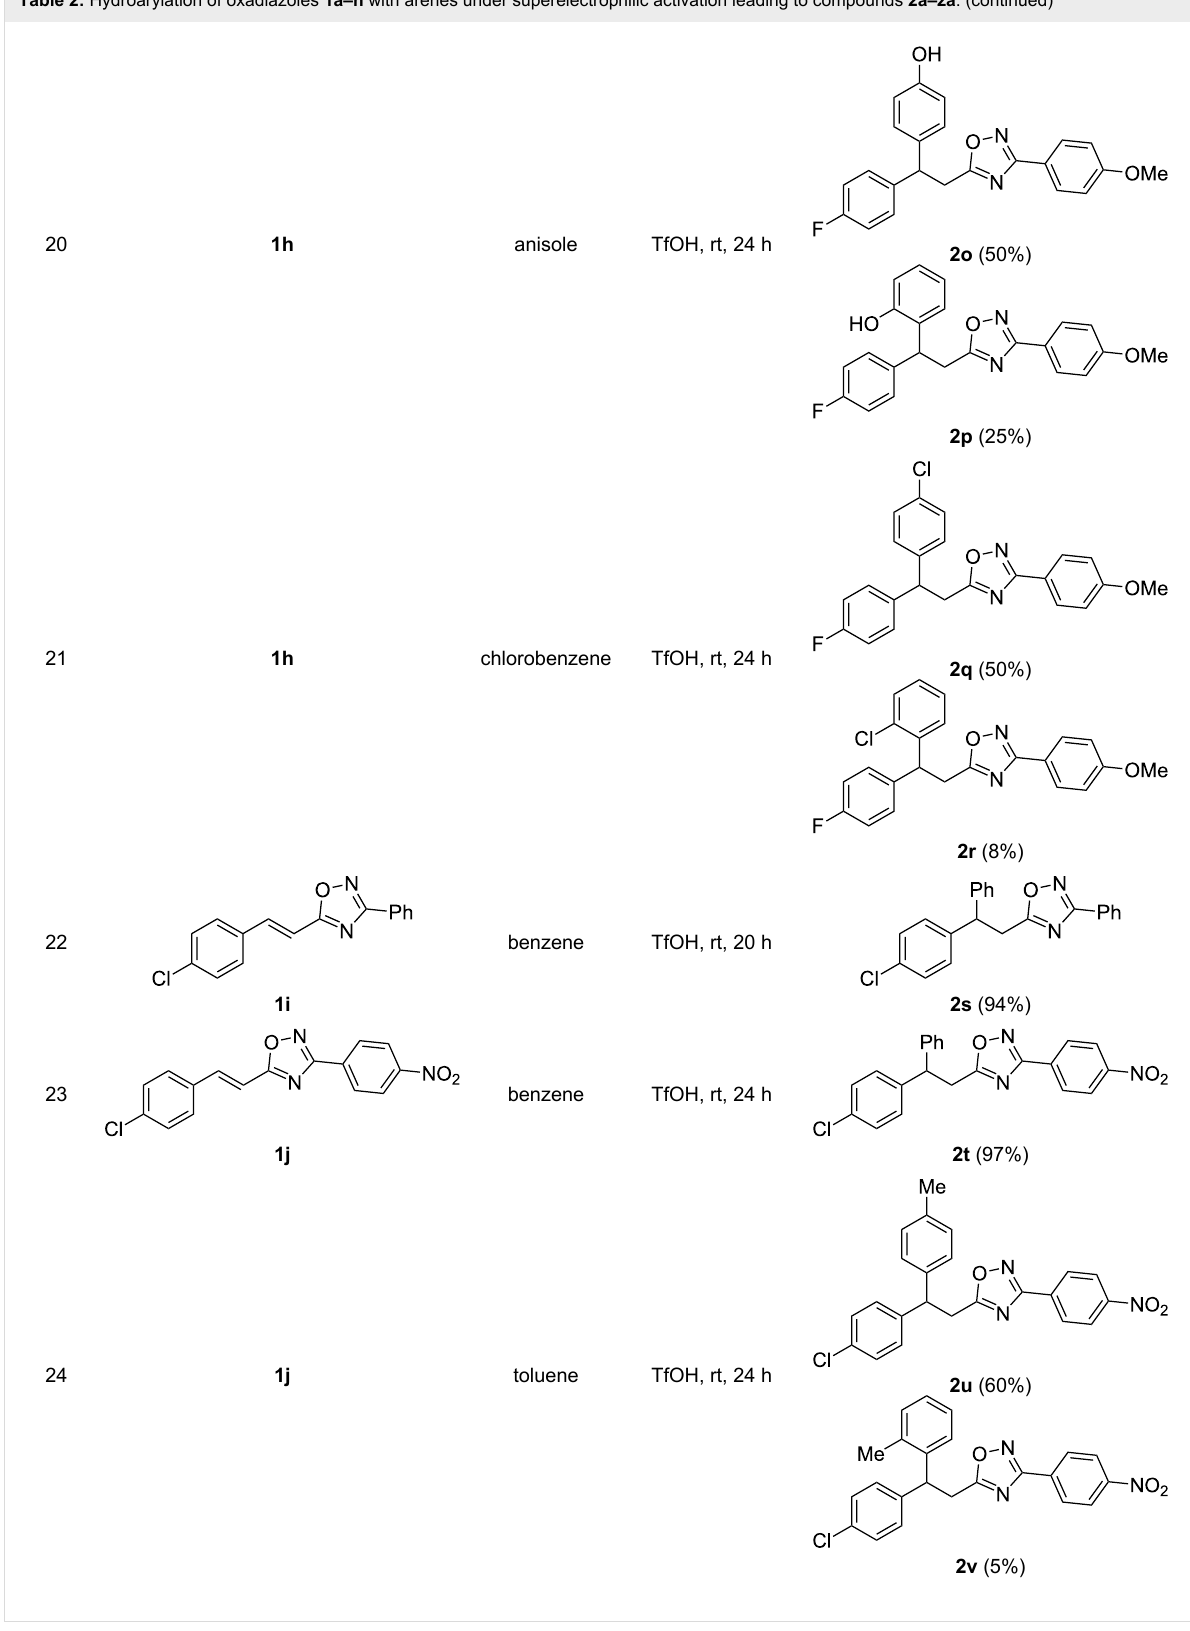
Table 2: Hydroarylation of oxadiazoles 1a–n with arenes under superelectrophilic activation leading to compounds 2a–za .